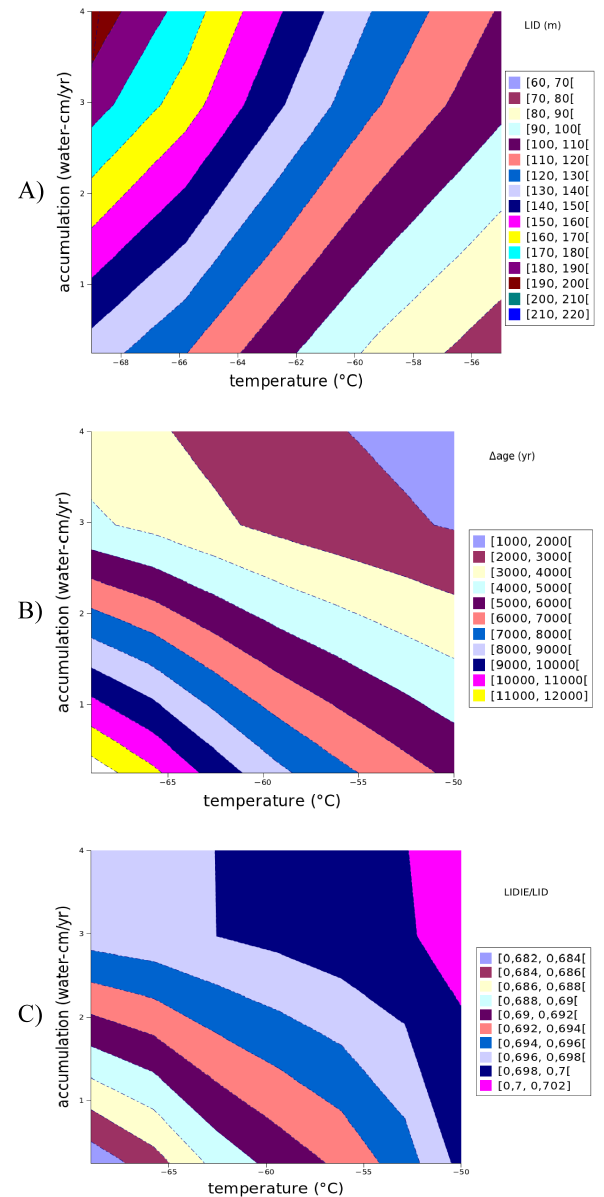
Fig. 3. Simulations of the Goujon/Arnaud firn densification model (Goujon et al., 2003), in a (surface temperature–surface accumula- tion) diagram. Surface density is 0.35gcm − 3 . LID is taken at 20% of closed porosity. (A) Simulated LID; (B) Simulated 1 age; (C) Simulated LIDIE/LID